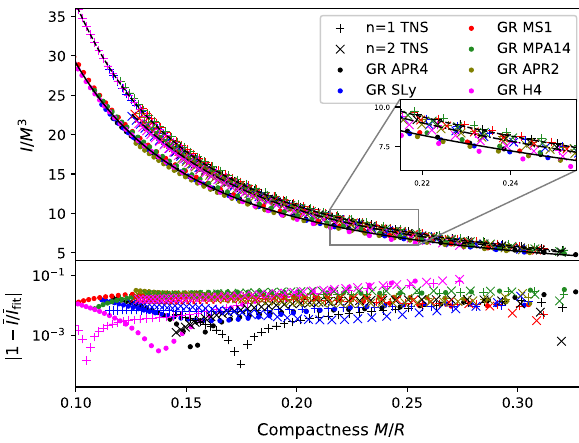
Fig. 8 The normalized moment of inertia ¯ I as a function of the com- pactness for GR and topological neutron stars with a coupling function (12), where we have chosen β = − 0 . 08. Dots show results for GR while pluses and crosses show results the Topological Neutron Stars of n = 1 and n = 2 respectively with the same color scheme for the EOS. Solid, dashed and dash-dotted lines show the corresponding fits following